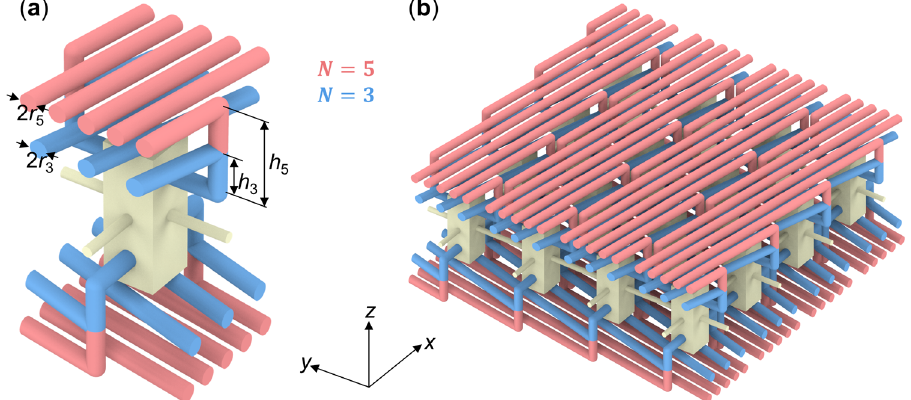
Fig. 2 Same as Fig. 1, but tubes (red) mediating the fi fth-nearest-neighbor interactions ( N = 5) are added as an example. a Single metamaterial unit cell. b 2D square lattice composed thereof. Clearly, yet further values of N could easily be implemented in other planes parallel to the xy -plane at other z -positions below and above the plane spanned by the yellow tubes ( N ¼ 1). Again, due a rotation-re fl ection symmetry of the overall structure, wave propagation along the x - and y -direction is